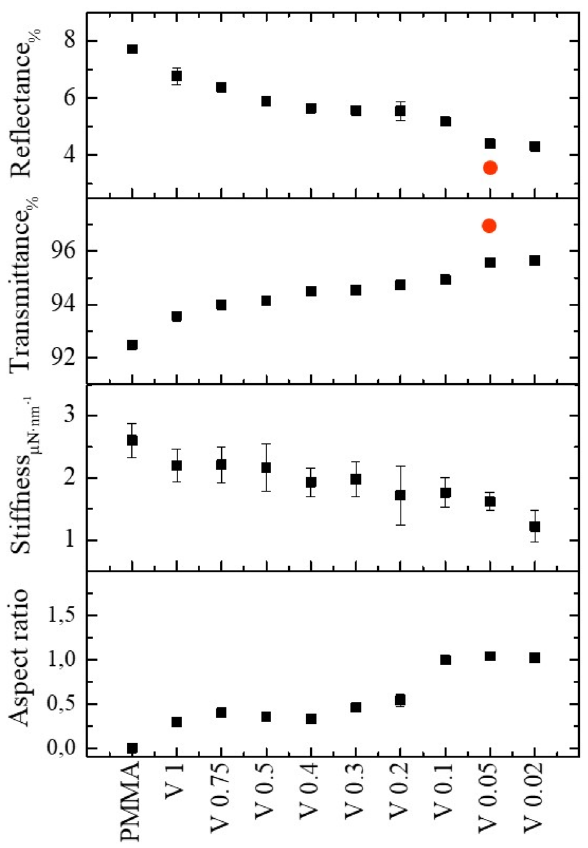
Figure 9. Summary of the R2R nanoimprinted moth-eye films characteristic parameters related to substrate topography, optical and mechanical performance as a function of the processing web speed obtained at constant roll temperature of 110 °C. Red circles correspond to the values obtained from two-side nanoimprinted PMMA